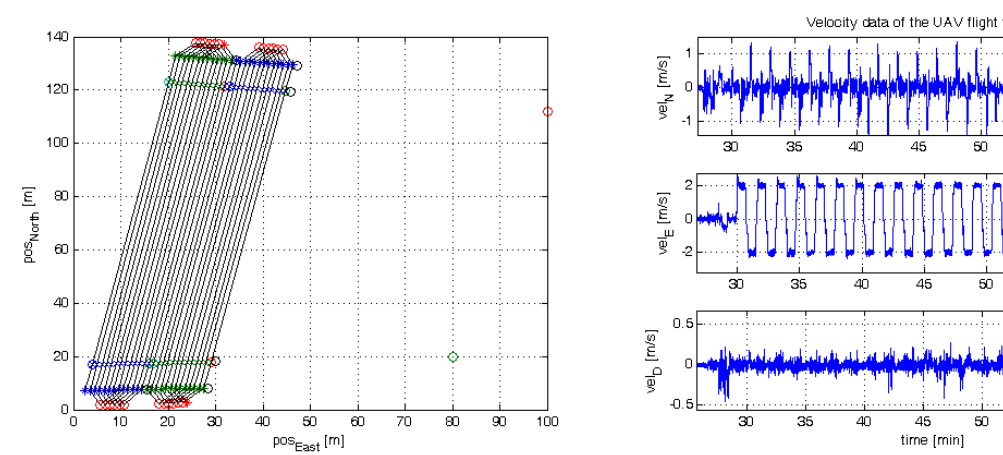
Figure 6: Advanced mission planning with additional segmenta- tion of the flight area and very small line spacing.